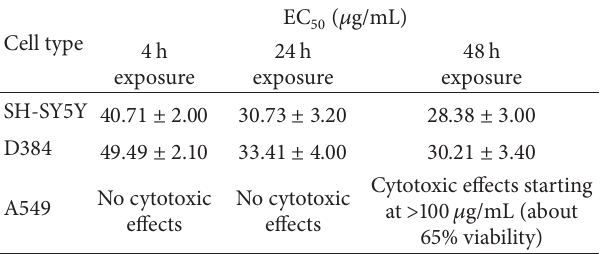
Table1:EC after4,24,and48 hexposuretoAgNPs(1–100 𝜇 g/mL). 50 values, 𝜇 g/mL) loss of Effective concentrations causing 50% (EC 50 cell viability (evaluated by MTT test) for SH-SY5Y, D384, and A549 cell lines following exposure to increasing concentrations of AgNP (0–100 𝜇 g/mL).